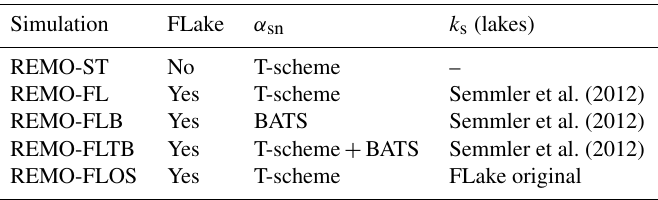
Table 1. Simulation names with the configurations showing whether FLake is used or not, which snow albedo scheme ( α sn ) is used and which snow heat conductivity ( k s ) method is used.